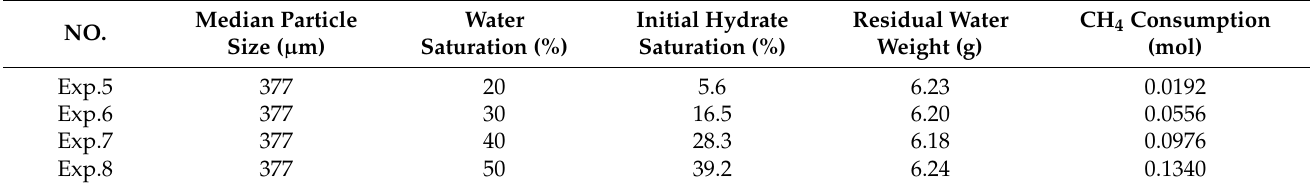
Table 3. Hydrate formation at different initial water